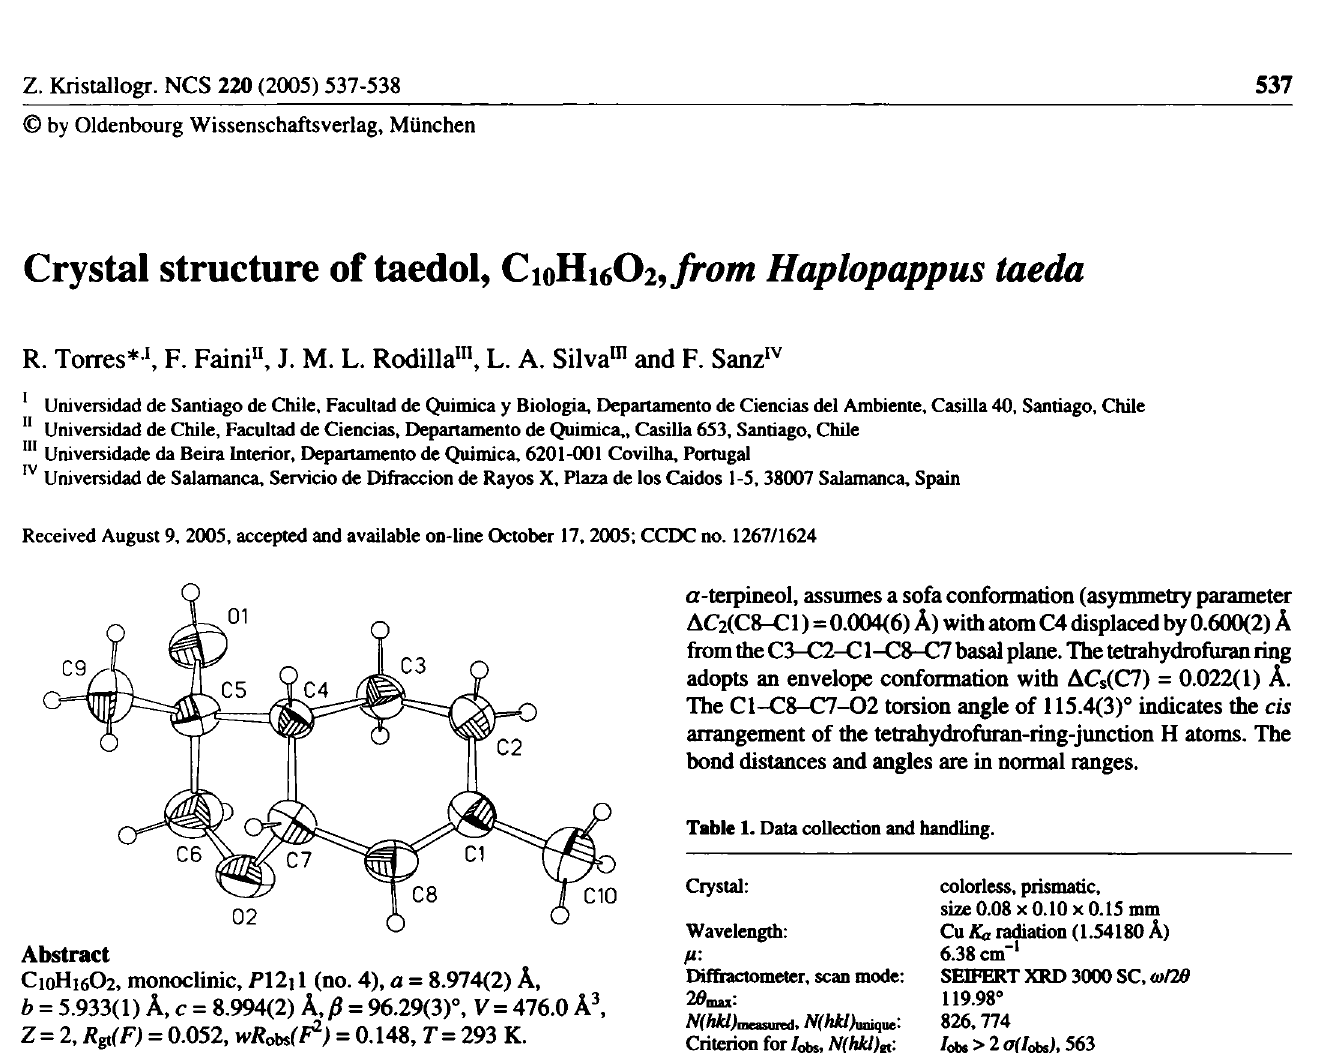
Table 2. Atomic coordinates and displacement parameters (in A 2 ).